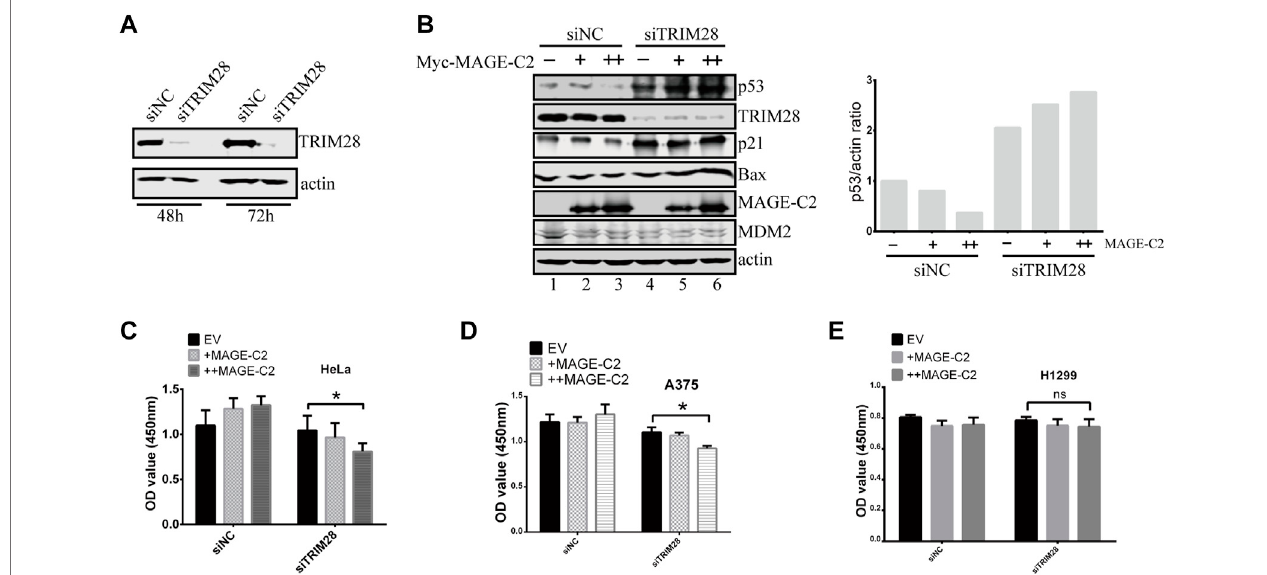
FIGURE 3 | The inhibitory role of MAGE-C2 in p53 ubiquitination and cell proliferation is antagonized by TRIM28. (A) The RNA interference was utilized to knock down TRIM28. siRNA transfection was performed and the protein levels of TRIM28 were signi fi cantly decreased within 72 h. (B) The protein levels of p53 and other proteins were detected by using Western blot with indicated antibodies. HeLa cells were transfected with RNAi – TRIM28 and wild-type Myc-MAGE-C2 followed by immunoblotting with the indicated antibodies. (C) CCK-8 cell proliferation assay was performed to evaluate the cell viability in HeLa cells at 36 h. Average and SD are shown here. * p < 0.05. +: 1 μ g MAGE-C2, ++: 2 μ g MAGE-C2. (D) CCK-8 cell proliferation assay was performed to evaluate the cell viability in A375 cells at 36 h. Average and SD are shown here. * p < 0.05. +: 1 μ g MAGE-C2, ++: 2 μ g MAGE-C2. (E) CCK-8 cell proliferation assay was performed to evaluate the cell viability in H1299 cells at 36 h. Average and SD are shown here. ns denotes no signi fi cance. +: 1 μ g MAGE-C2, ++: 2 μ g MAGE-C2.